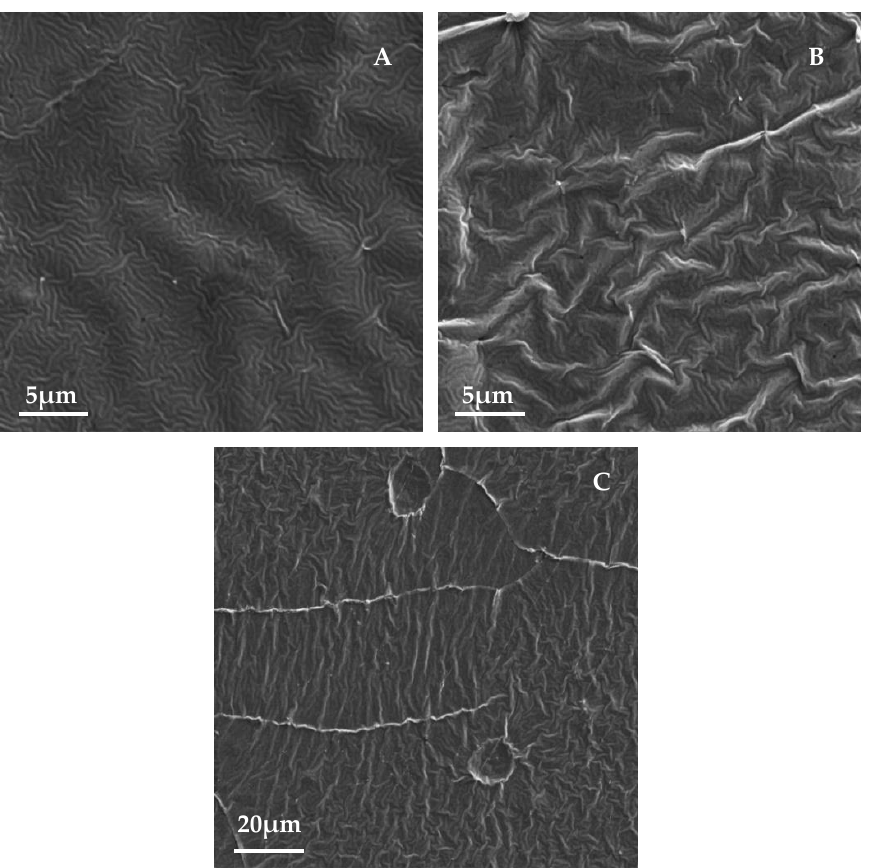
Figure 3. Image of the surface of the unheated sample taken by the SEM method. Layers of gold and titanium with a thickness of 10 and 20 nm, respectively, were deposited on the sample ( A ). The same sample after heating processing ( B ). SEM image of the heated sample with a gold bottom layer and a titanium top layer of 2 and 28 nm thicknesses, respectively ( C ).